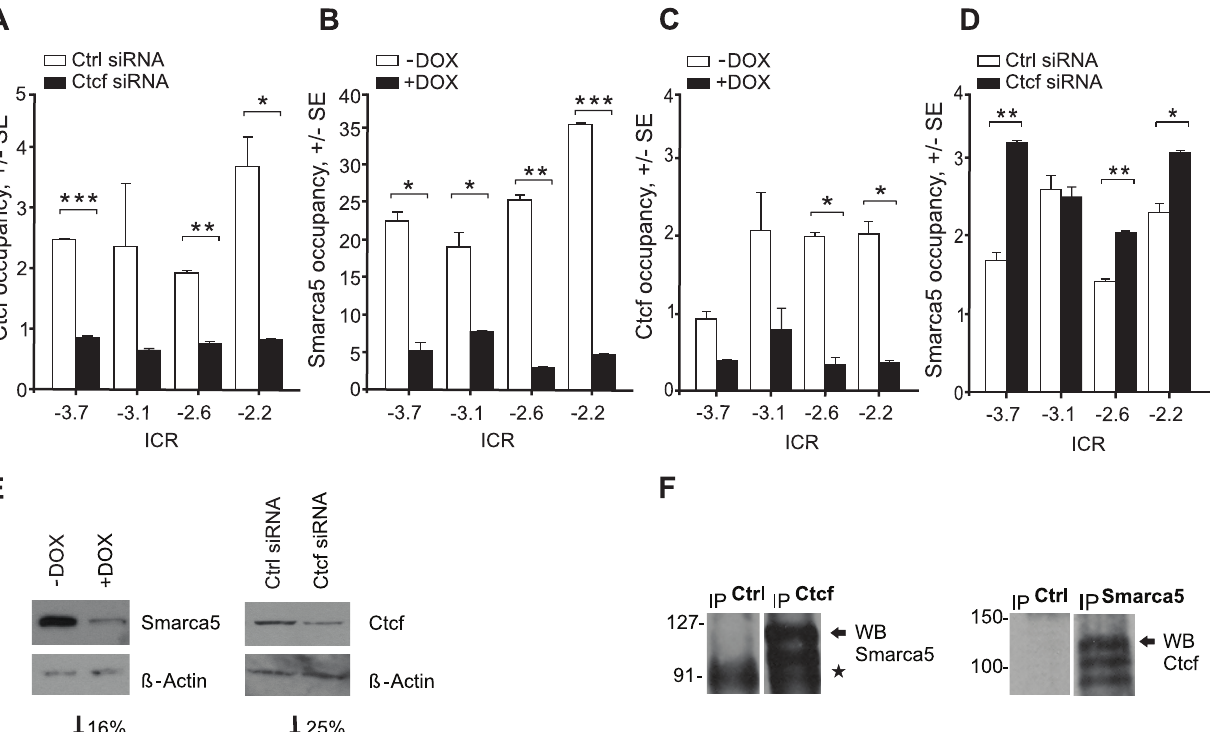
Figure 1. Ctcf and Smarca5 interact in AML cells. A Ctcf occupancy at ICR. ChIP of Ctcf-siRNA-treated MEL cells (Ctcf siRNA, black bars) or non- specific siRNA (Ctrl siRNA, white) at 72 hrs. Y-axis: specific IP DNA fragment enrichment over control IP (standard error, SE). X-axis: ICR amplicons (relative to H19-TSS). Asterisks: p-values (t test, 0.05–0.005). B Smarca5 occupancy at ICR. MEL-shSmarca5 treated 48 hrs with doxycycline ( + DOX, black bars) or untreated (-DOX, white). C Ctcf occupancy is decreased at the ICR upon Smarca5 knockdown. Occupancy of Ctcf (lysates from 1B) determined by ChIP. D Smarca5 at ICR upon Ctcf knockdown. Occupancy of Smarca5 (lysates from 1A) by ChIP. E Knock-down of Smarca5 and Ctcf. Protein lysates from samples 1A and 1B were analyzed by Immunoblotting. Migration of Ctcf, Smarca5, and b -actin bands are indicated. Level of downregulation (bellow blots) was determined by densitometry. F Co-IP of Smarca5 and Ctcf in MEL cells. Antibodies for IP and detection are indicated; asterisk indicates nonspecific signal.